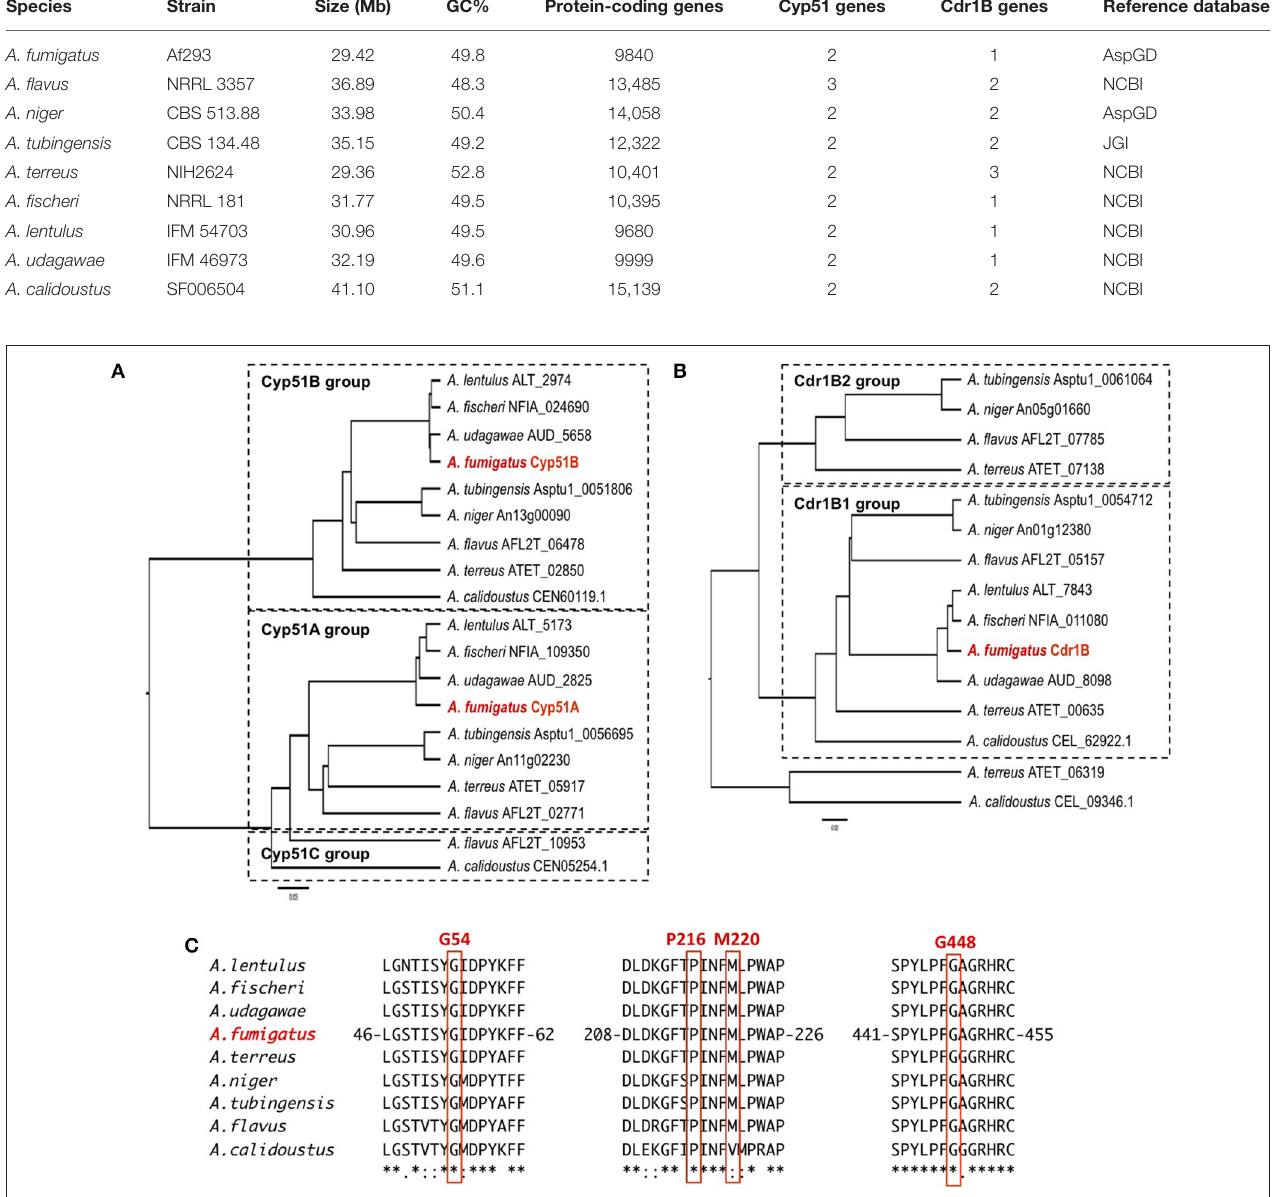
FIGURE 3 | The molecular genetic phylogenetic trees of the Cyp51A and Cdr1B proteins of pathogenic Aspergillus fungi. The sequences were retrieved from the AspGD and NCBI databases according to sequence similarity. The protein sequences of Cyp51A (A) and Cdr1B (B) were aligned using the ClustalW software, and the phylogenetic trees were constructed by the UPGMA method. The trees were drawn using FigTree v1.4.2 software. The IDs shown behind a species name are associated with the database from which the sequences were retrieved. (C) Amino acid sequence alignment of Cyp51A. The sequence surrounding the azole resistance-related amino acids (G54, P216, M220, and G448) is depicted. The numbers indicate amino acid position in the A. fumigatus Cyp51A